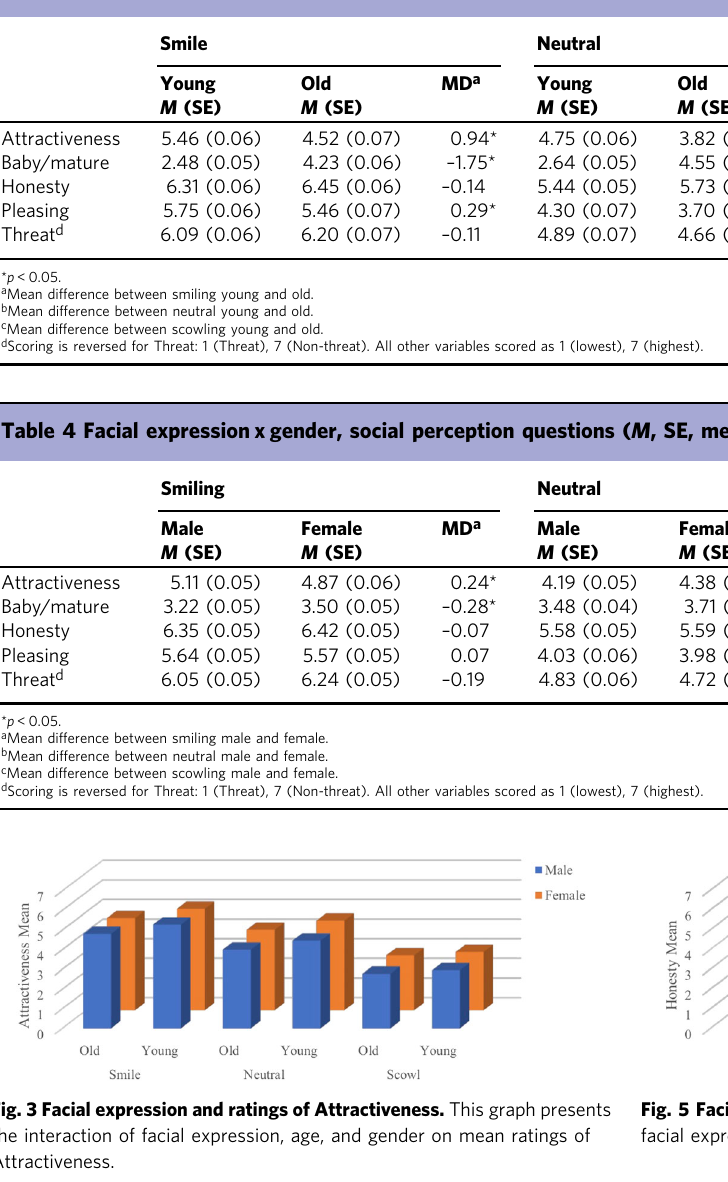
Table 3 Facial expression x age, social perception questions ( M , SE, mean difference).